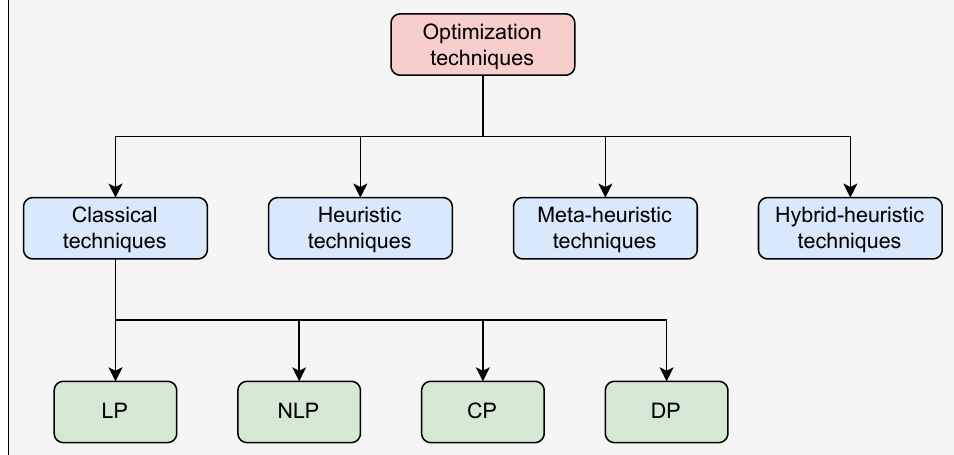
Figure 6. Classification of optimization